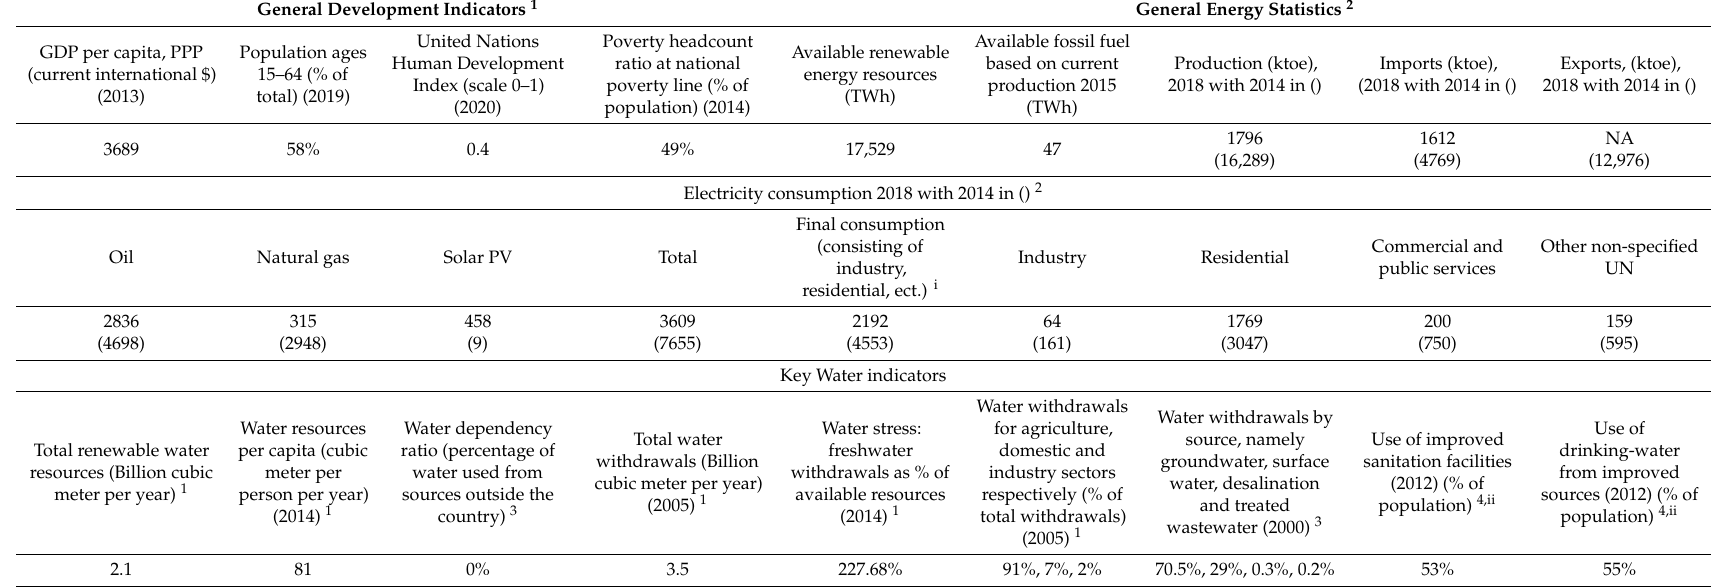
Table 2. Key development, energy, and water statistics for